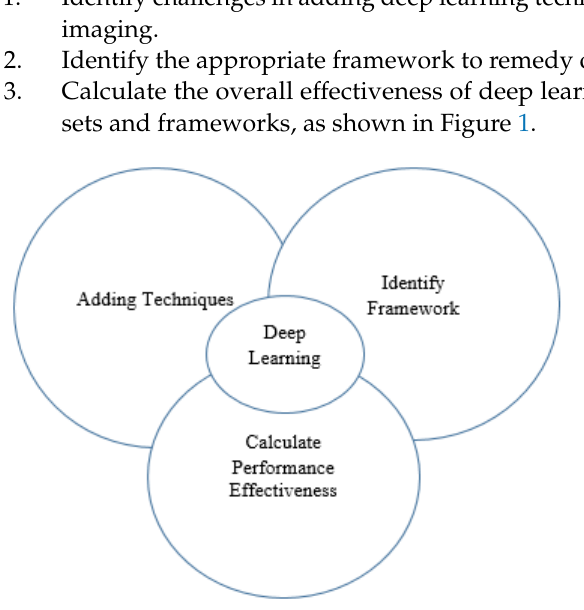
Figure 1. The goal of the